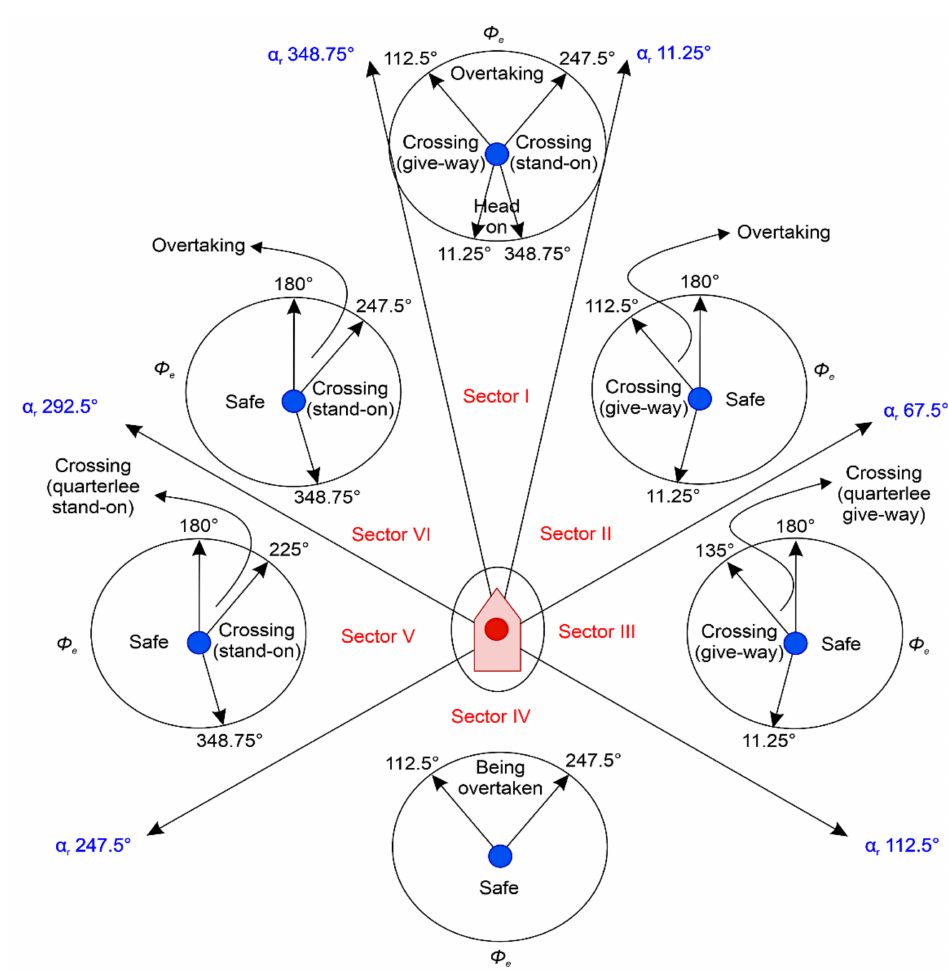
Figure 2. Decisions for different encounter relations ([3]. 2022, Namgung, H.).